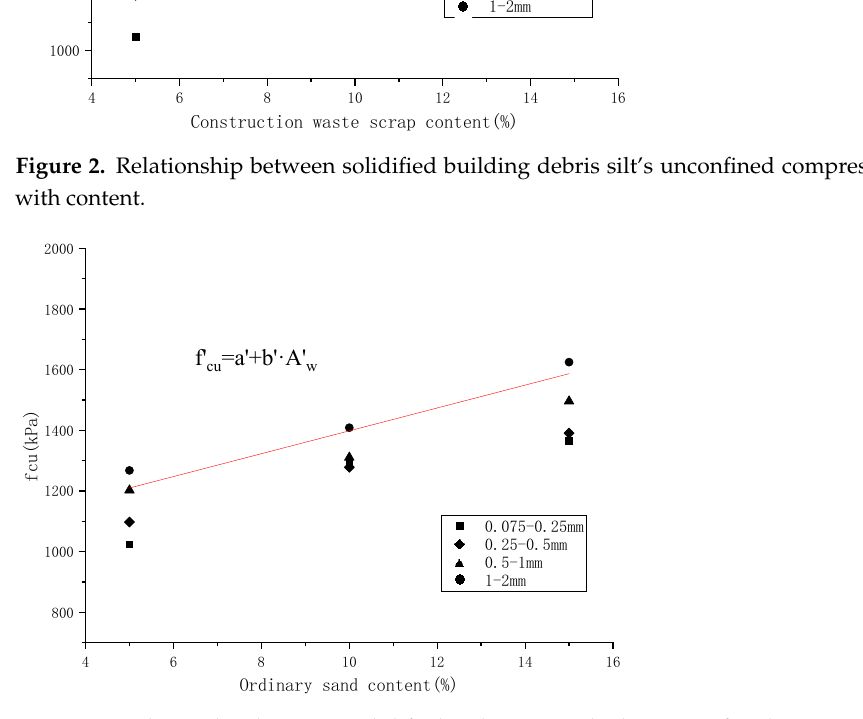
Figure 3. Relationship between solidified ordinary sand silt’s unconfined compressive strength with content.